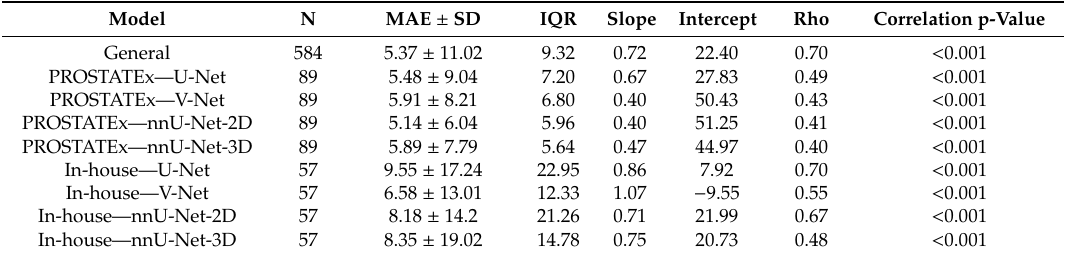
Table 1. The performance evaluation of the separately tested models.